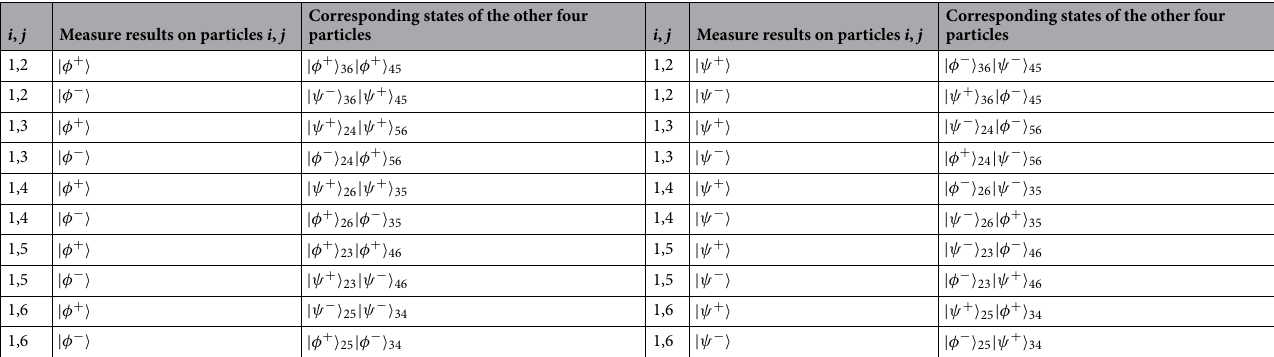
Table 1. The other four qubits will collapse to tensor product of two pairs of EPR when we measure the BPB state on any two qubits i , j (for example, i=1) with the Bell basis.